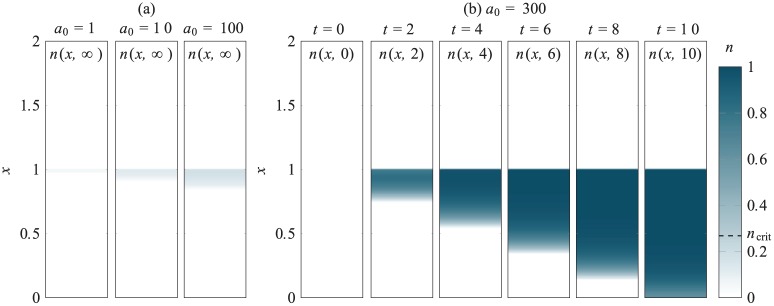
Chondrocyte densities for case study 2 (see Figure 4(b)), where MSC differentiation is induced through the initial addition of exogenous TGF-β of concentration a0 in the region 1<x<2: (a) Examples of partially differentiated steady states for a0=1,10and100 and (b) for a0=300, the initial MSC population fully differentiates, and this process is shown at six time points here. Note that in the last time step shown here, a few MSCs remain, but these will be differentiated at later times.